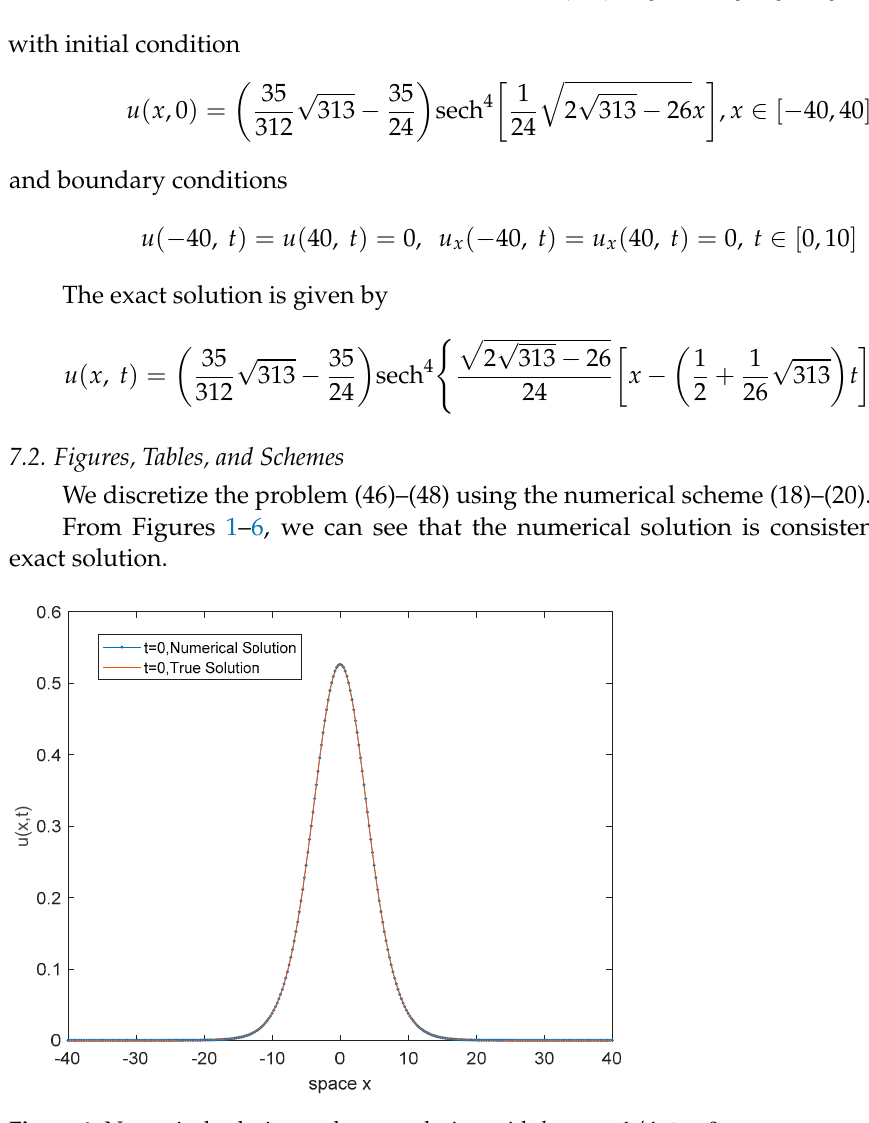
Figure 1. Numerical solution and exact solution with h = τ = 1/4, t =